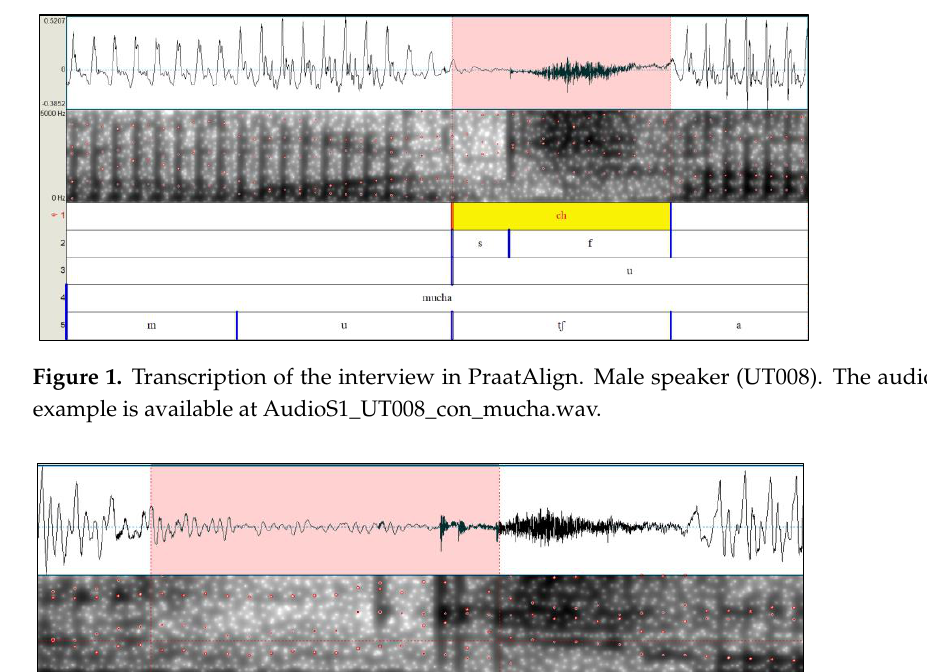
Figure 2. Coding of [ ʧ ] in the word aprovechó “ took advantage of ” . The affricate has a stop section with several releases. Male speaker (UT002).